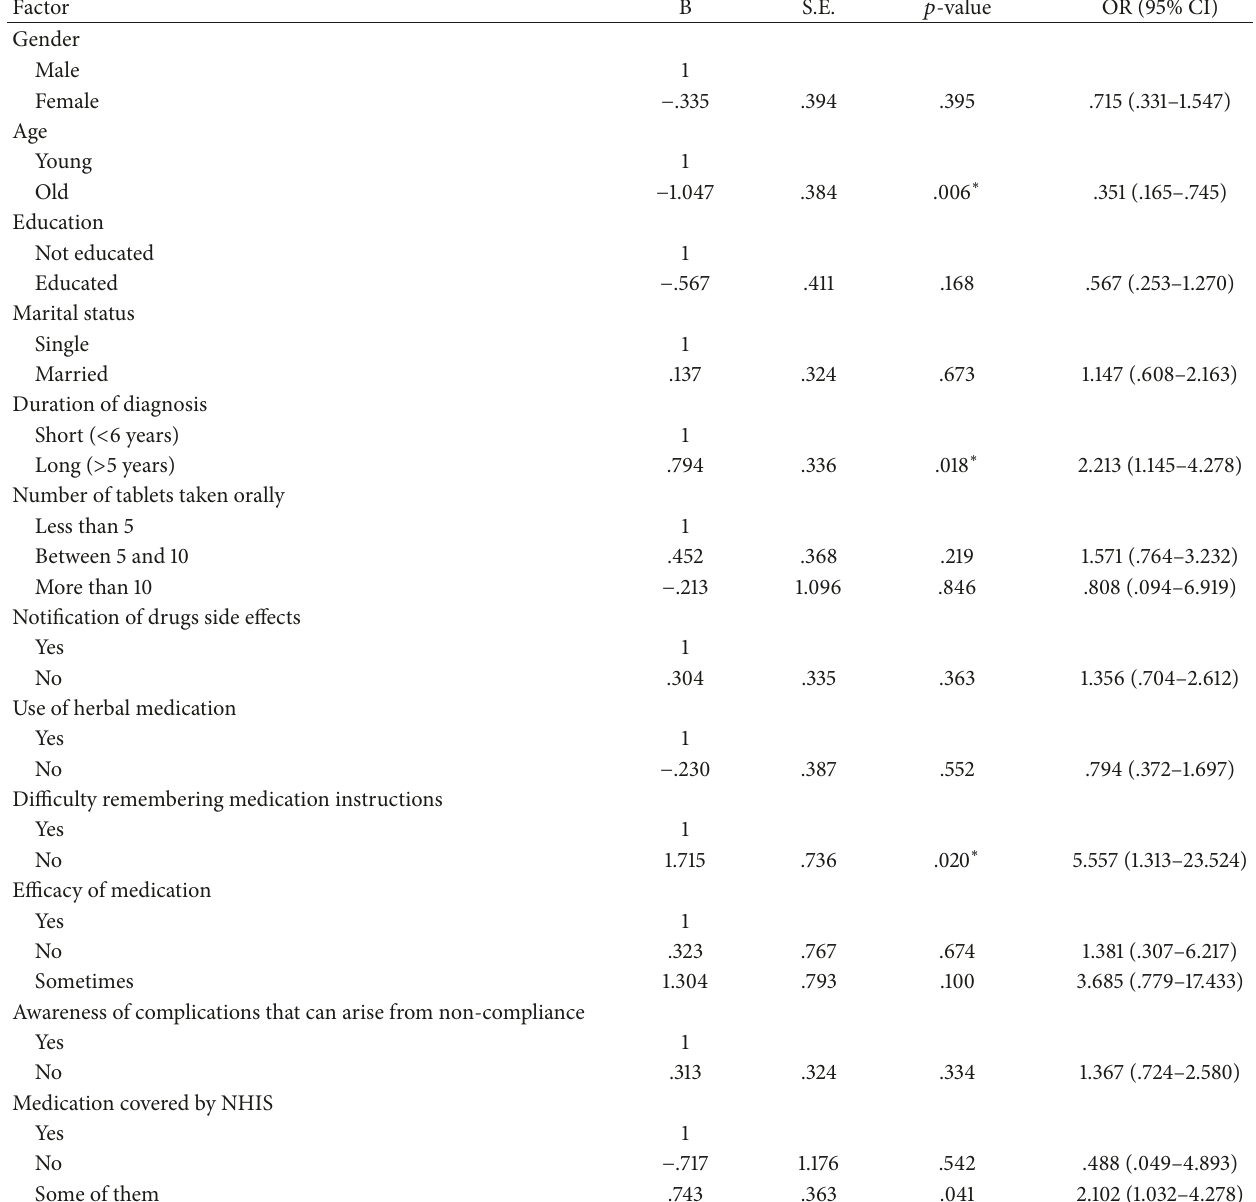
Table 4: Multivariate analysis of risk factors for medication